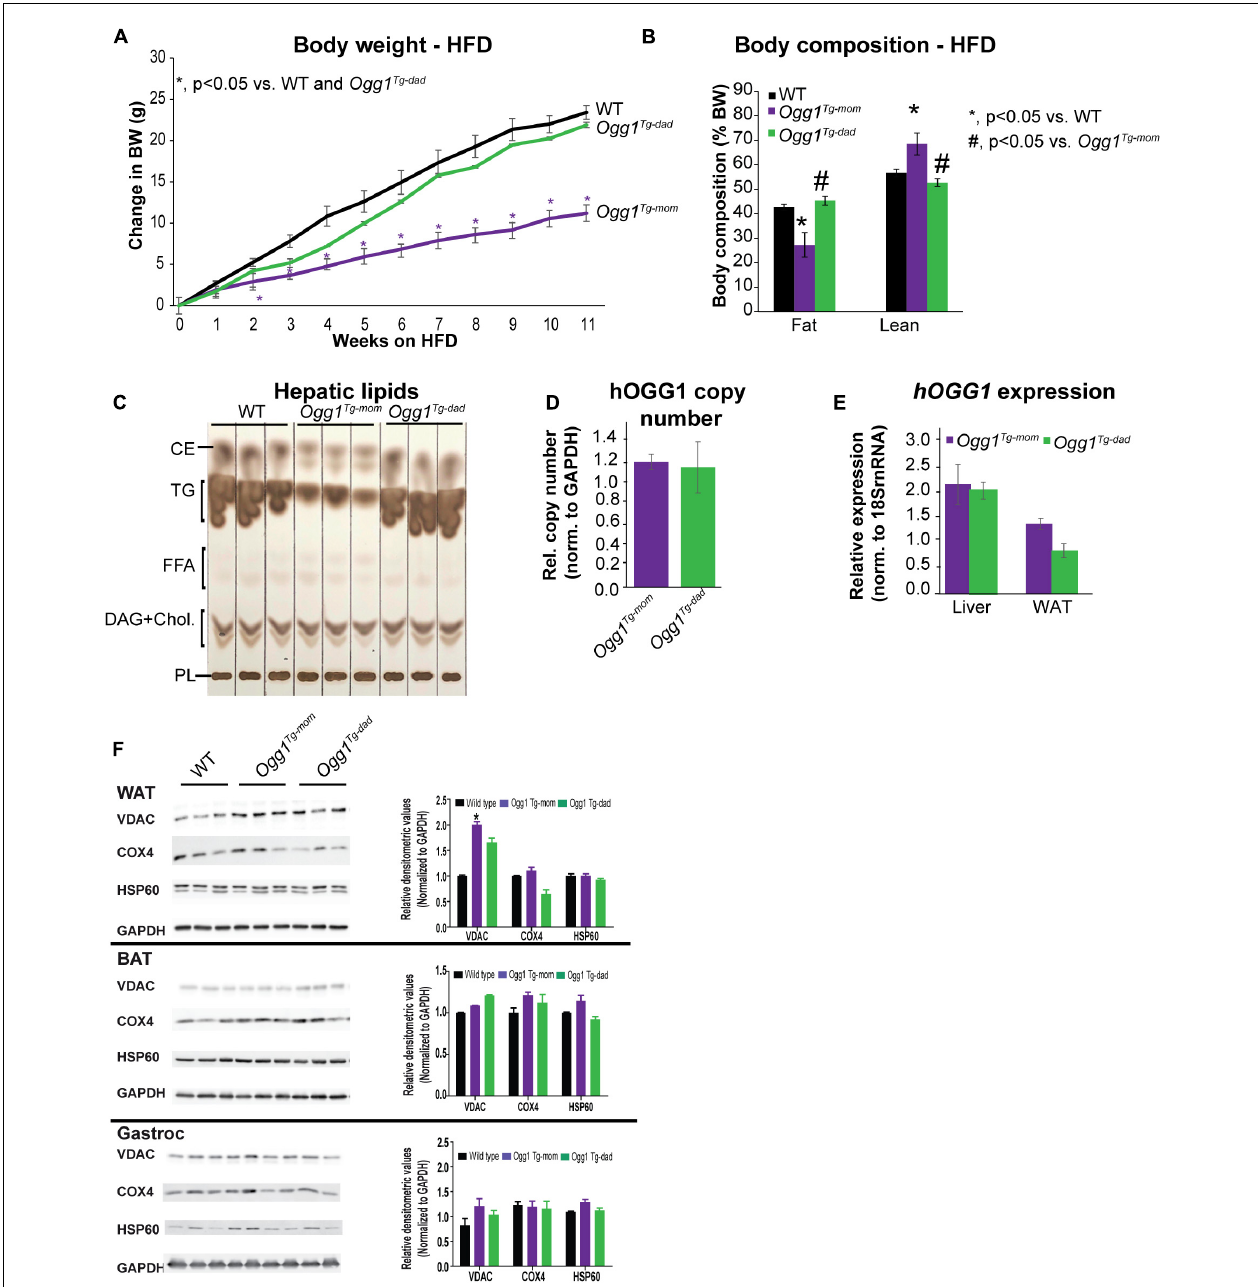
FIGURE 5 | Maternal vs. paternal transmission of hOGG1 influences metabolic phenotype and mitochondrial content of WAT. (A) Ogg1 Tg - mom or Ogg1 Tg - dad animals were placed on high-fat diets (HFDs) at 8 weeks of age, and body weights were measured weekly. (B) Body composition was measured at the end of 11 weeks of HFD feeding. (C) Hepatic lipids were extracted and separated by thin-layer chromatography. (D) Relative hOGG1 copy number and (E) hOGG1 gene expression were measured by qPCR. (F) Tissue expression of mitochondrial markers was measured by immunoblotting. CE, cholesterol esters;